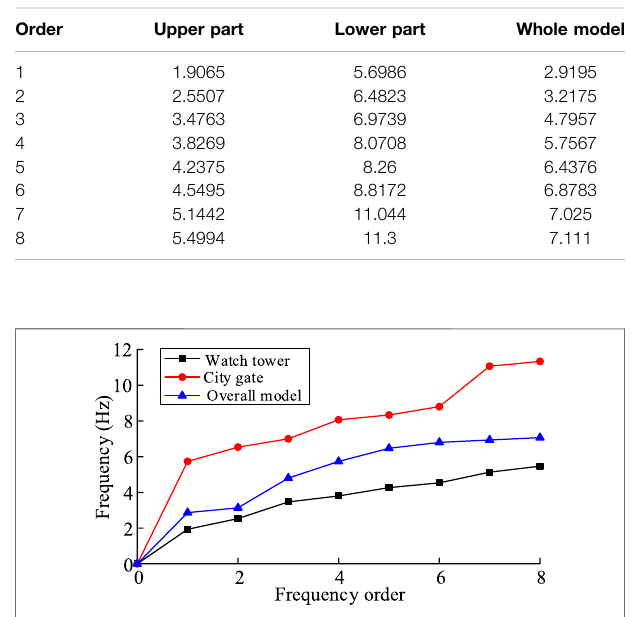
TABLE 5 | Natural frequency of the Drum Tower